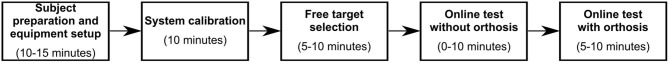
Different stages of the experiment designed for evaluating the mind-controlled hand-orthosis. An experimental session started with the subject preparation and system setup. Then, the participant trained the BMI and tested the interface freely. Finally, the experiment concluded with the online tests. A complete experiment lasted approximately from 30 to 55 min.